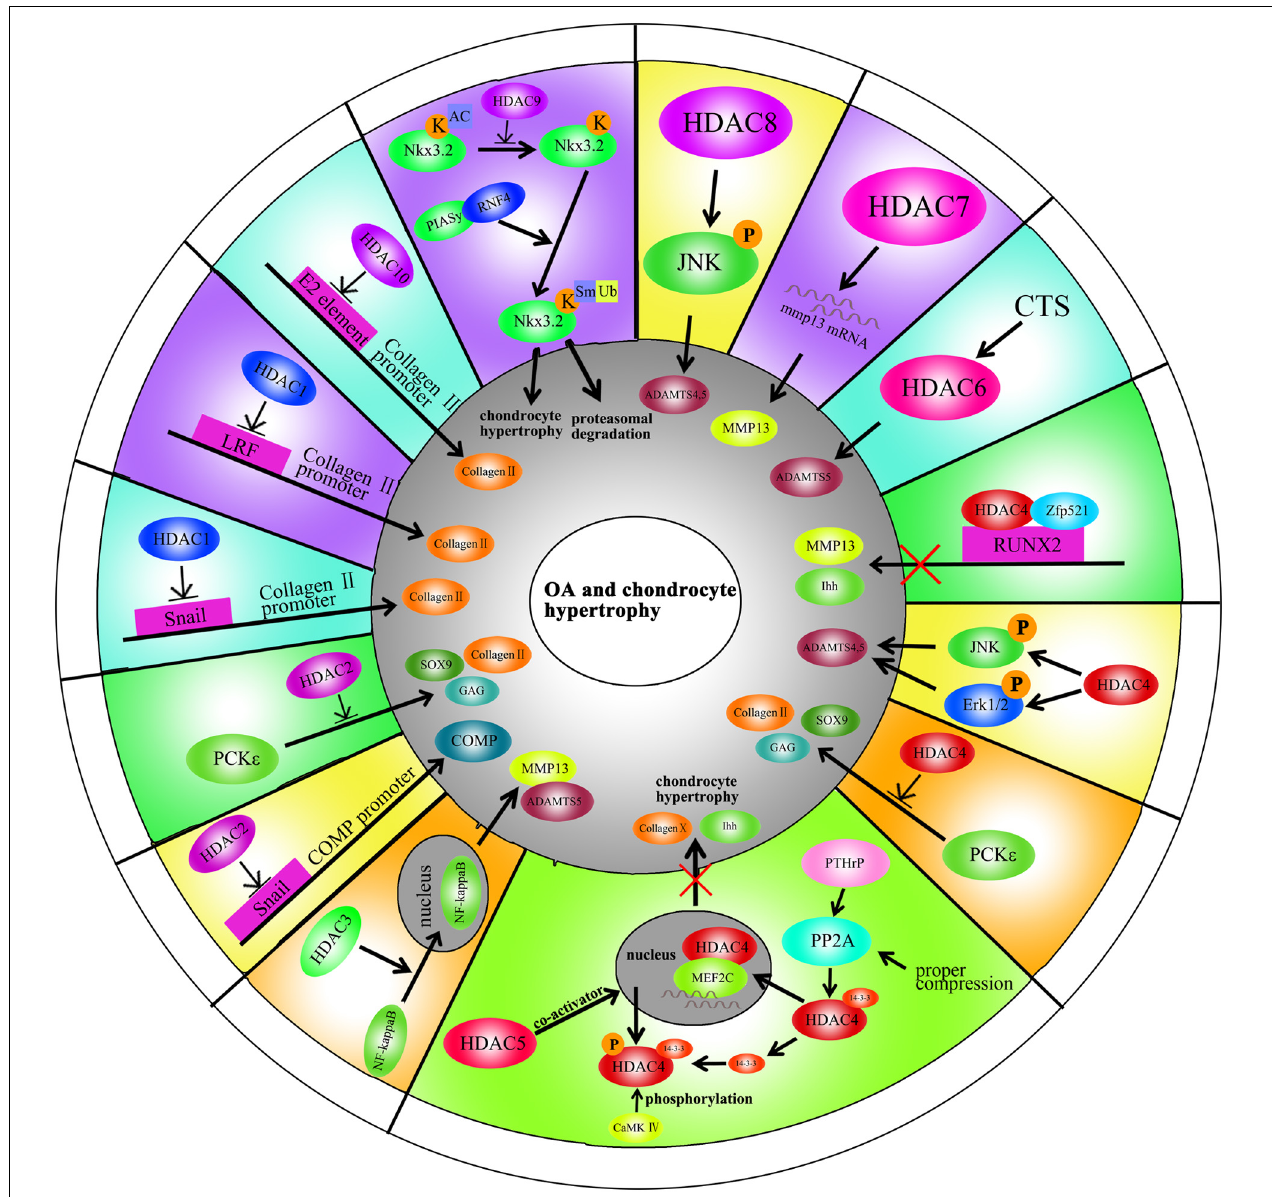
FIGURE 3 | A schematic illustration of HDACs in OA and chondrocyte hypertrophy through different signaling